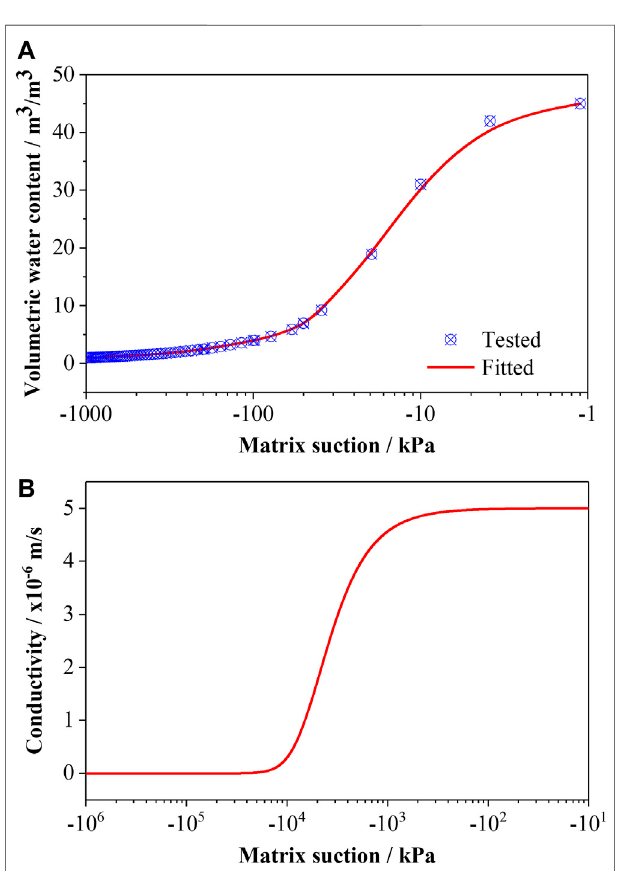
FIGURE 5 | Soil-water characteristic curve (A) and hydraulic conductivity curve (B) of the loess.